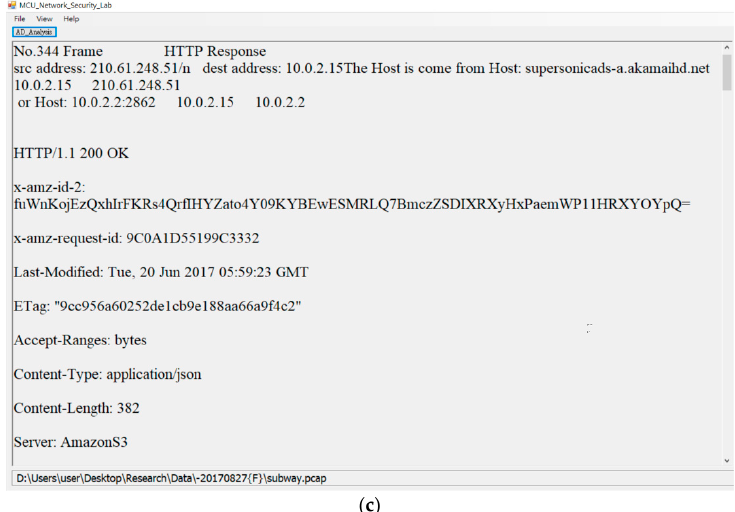
Figure 2. The proposed tool for obtaining advertising behavior: ( a ) Partial program; ( b ) Ad request; ( c ) Ad reply.